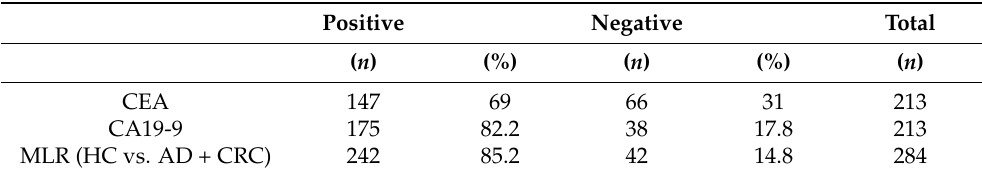
Table 5. Comparison of the positive rate between tumor markers and multiple logistic regression (MLR) model.